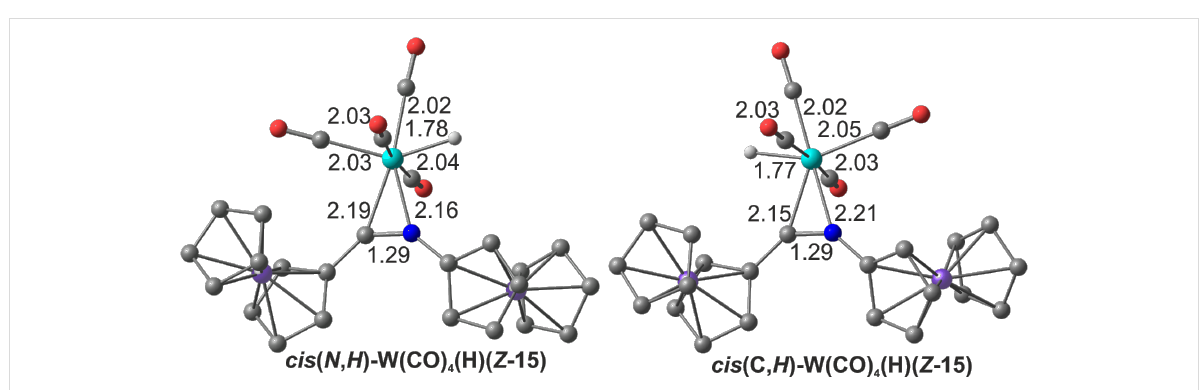
Figure 2: DFT calculated geometries of the two hydrido intermediates cis ( N , H )-W(CO) 4 (H)( Z -15) and cis ( C , H )-W(CO) 4 (H)( Z -15) and selected bond distances in Å.